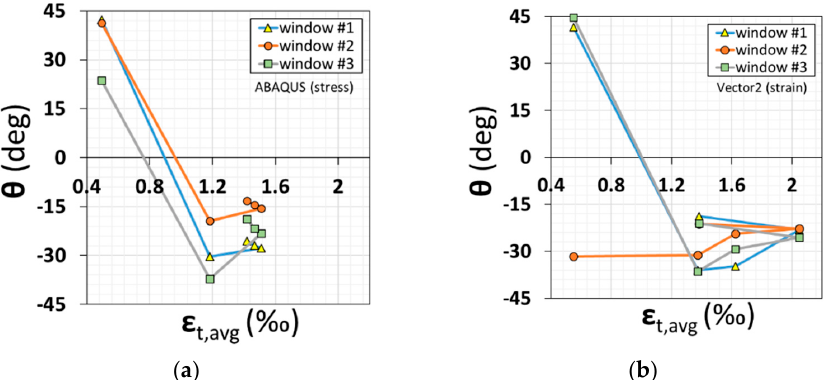
Figure 9. Variations in the angle of inclination of the web-shear crack according to the average tensile strain of the bottom reinforcement. ( a ) ABAQUS. ( b ) Vector2.